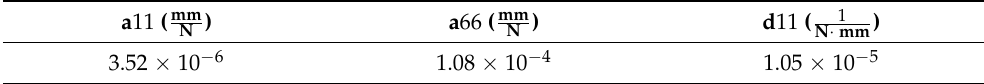
Table A5. Laminate with [0/0/0/0/0] s layup compliance components.